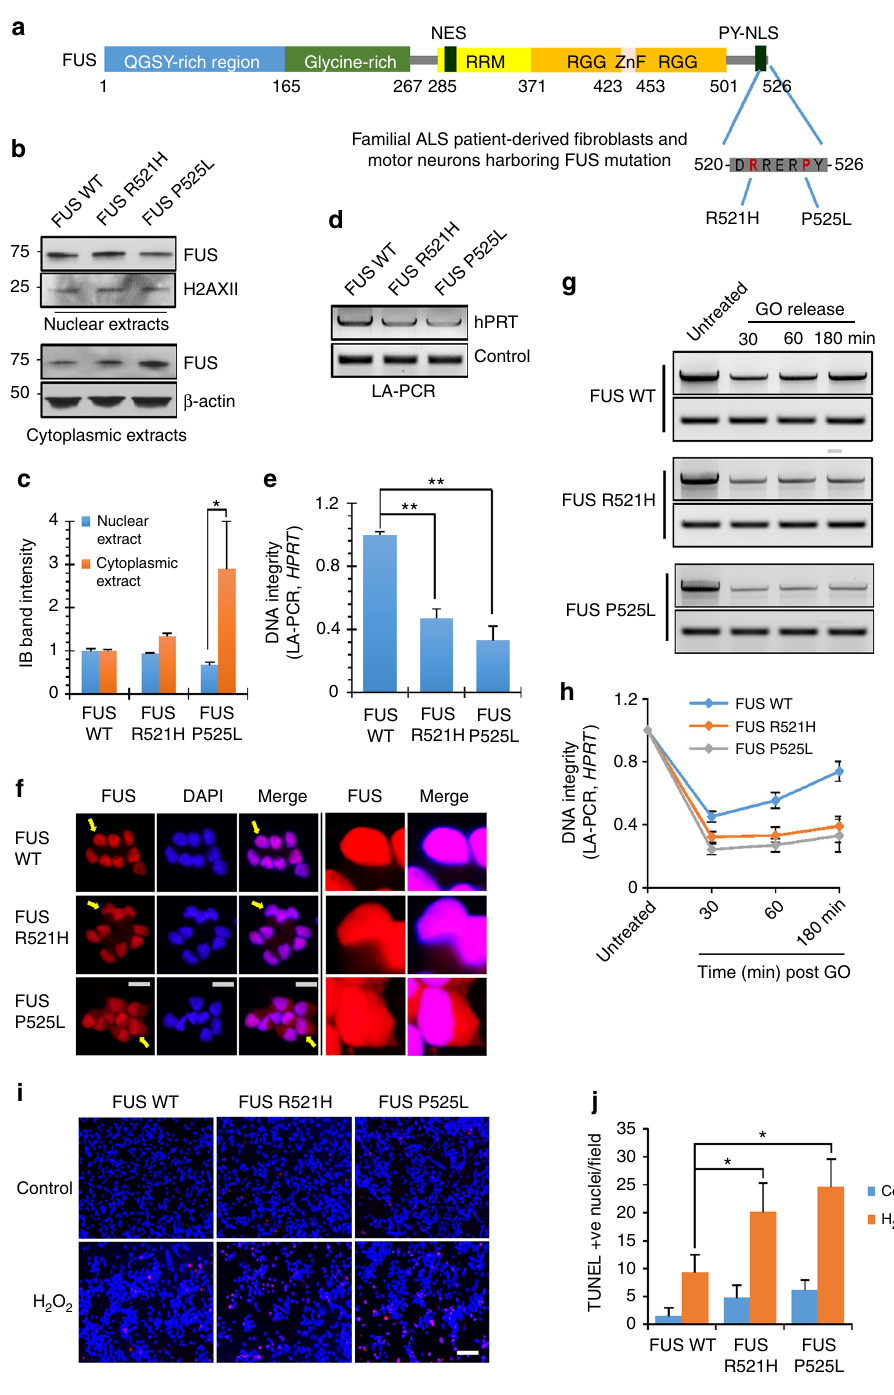
activity in XRCC1 IP isolated from control vs 50% FUS KD cells. 50% KD was con fi rmed by both mRNA quanti fi cation (Fig. 7f) and immunoblotting of protein level (Fig. 7g, h). Incubation with 15 nM ASOs for one week caused ~50% KD of FUS in motor neurons. The 50% FUS KD cells showed a moderate (~20%) reduction in LigIII activity (Fig. 7i, j; Lane 1 vs 2). We then compared the LigIII activity in the patient-derived R521H mutant FUS cell line with the FUS KD line. Theoretically, the heterozygous mutant line derived from an ALS patient is expected to have 50% WT and 50% mutant FUS. However, the ligase activity in mutant motor neurons was signi fi cantly lower NATURE COMMUNICATIONS| (2018) 9:3683 |DOI: